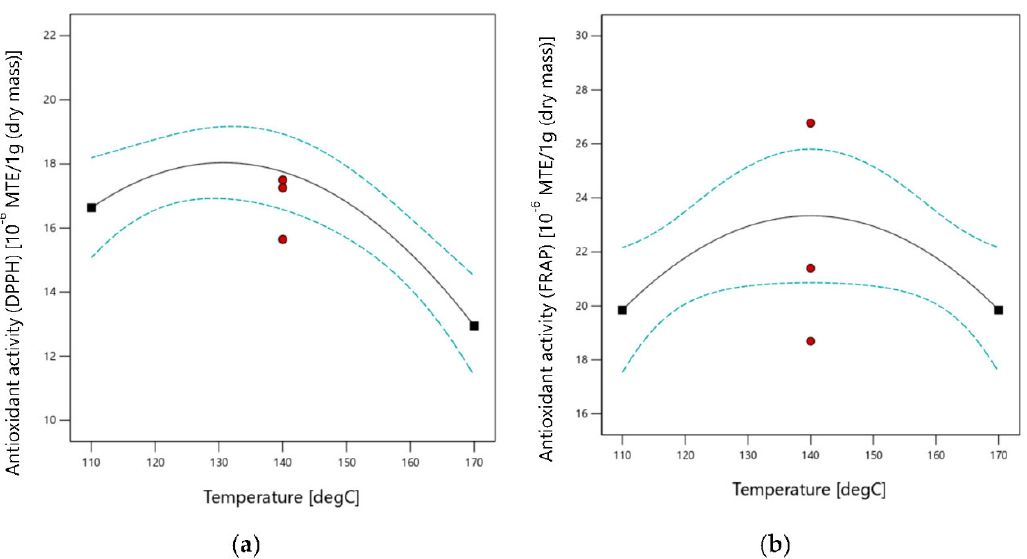
Figure 4. Antioxidant activity as a function of extraction temperature ( a ) Analyzed using DPPH method; ( b ) Analyzed using FRAP method.